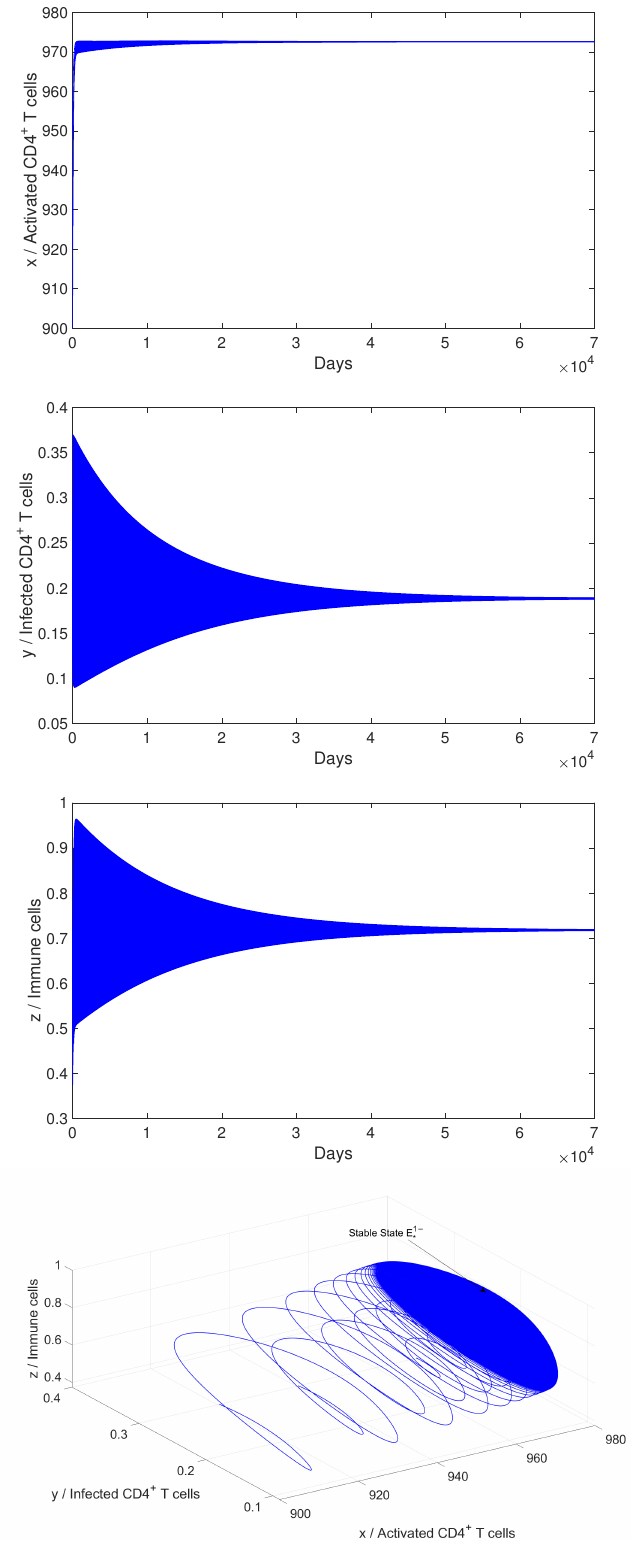
Figure 8. Time histories and trajectories of system (1) with different initial values for c = 0.65 day − 1 . Only E 1 − ∗ is stable. Other parameter values are listed in Table